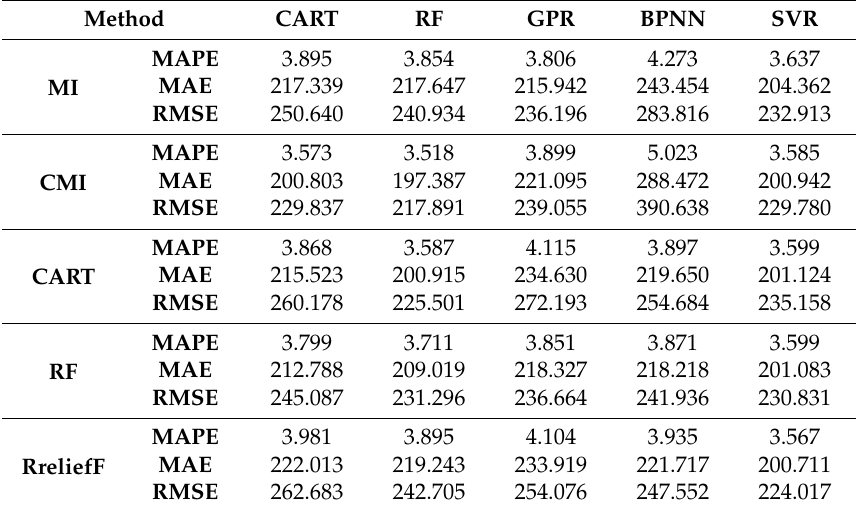
Table 12. Comparison of different combined